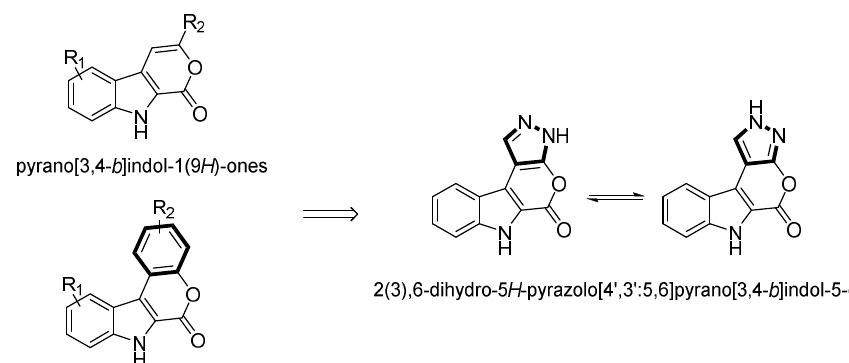
Figure 1. Pyrano- and chromeno-fused heterocycles of interest. Tautomerism of 2(3),6-dihydro-5 H - pyrazolo [4’,3’:5,6]pyrano [3,4- b ]indol-5-one.